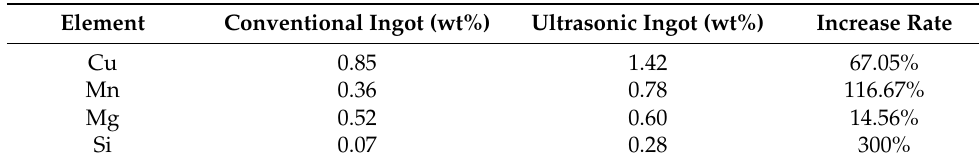
Table 3. Mass fraction of solute elements in crystal.